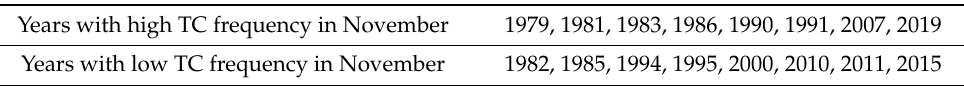
Figure 1. November TC frequency over the WNP basin from 1979 to 2019. The data was collected from the JTWC best track dataset. The solid line represents the climatological mean over the 41 years. Dashed lines stand for one standard deviation of TC frequency during 1979–2019. Table 1. Years with high ( ≥ mean value plus one standard deviation) and low ( ≤ mean value minus one standard deviation) TC frequency in November.